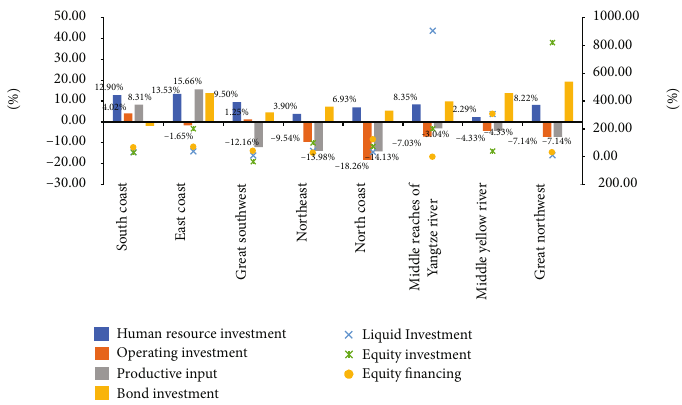
Figure 6: Productive investment ratio of family businesses. Table 1: Variable description.